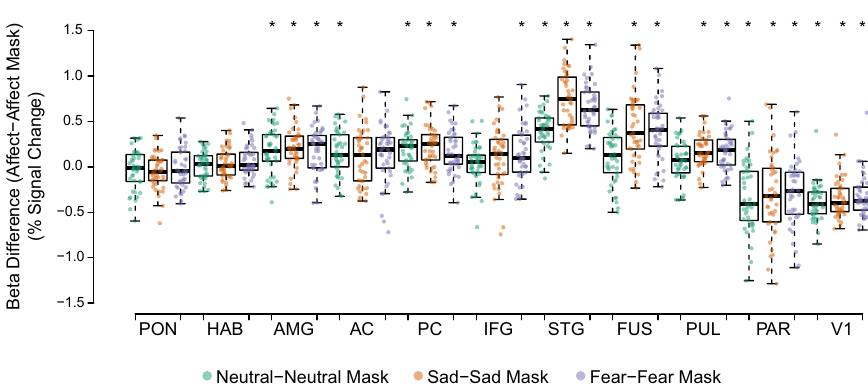
Fig. 1 GLM beta weight differences (% signal change) between affect stimuli and corresponding masked stimuli. Differences in beta weights pertaining to each affective condition and its corresponding masked condition. Beta weights tested using paired t -tests. *signi fi cant results ( p FWE < 0.05). Whiskers: ±1.5 × interquartile range ( N = 41). AC anterior cingulate cortex, AMG amygdala, FUS fusiform, HAB habenula, IFG inferior frontal gyrus, PAR parietal, PC posterior cingulate cortex, PON pons, PUL pulvinar, P/PC precuneus/posterior cingulate cortex, STG superior temporal gyrus, V1 primary